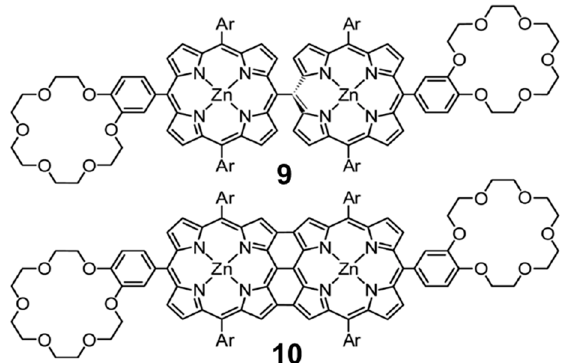
Figure 12. Chemical structure of the ditopic porphyrin-based hosts 9 and 10 .